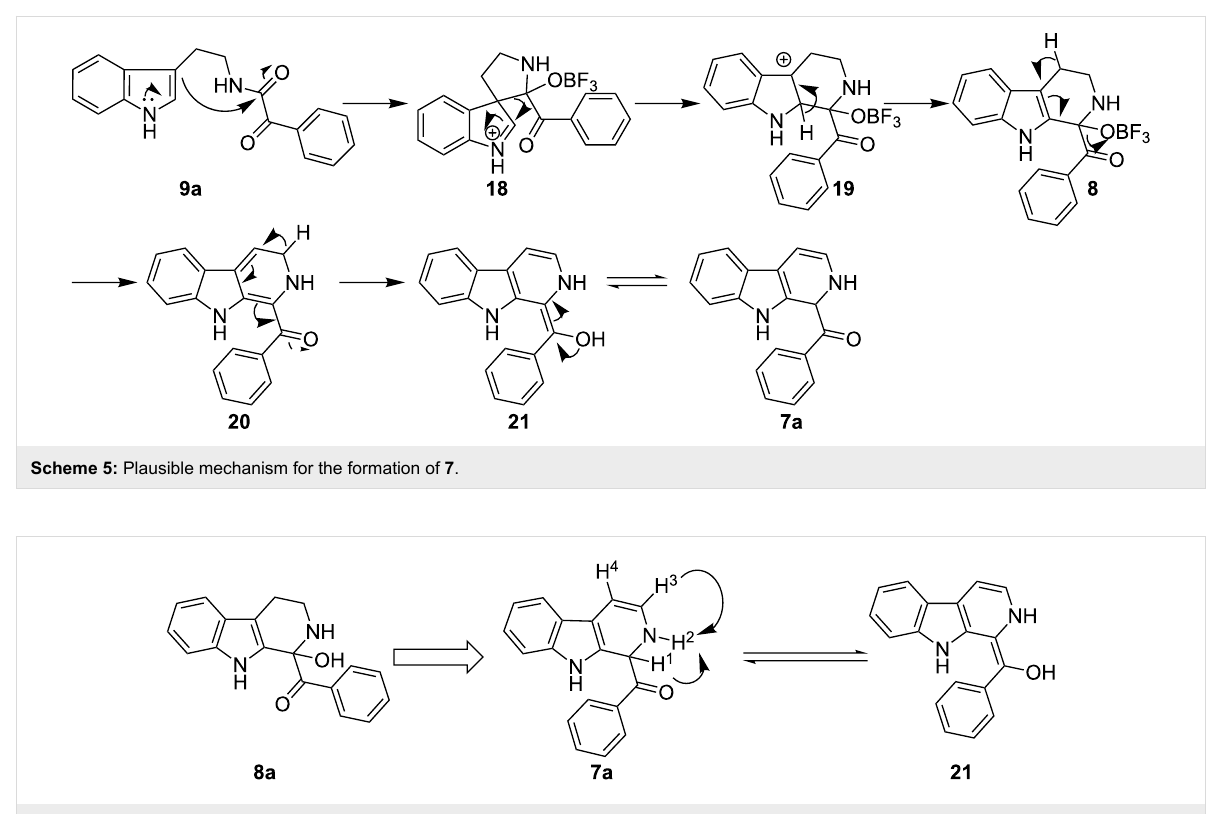
Scheme 6: Rearrangement of 8a into 7a and coupling interactions of 7a